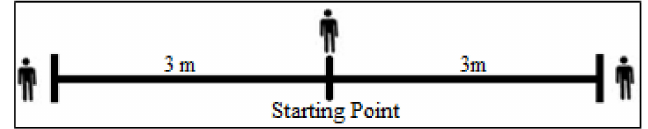
Figure 1. Special Wrestling Fitness